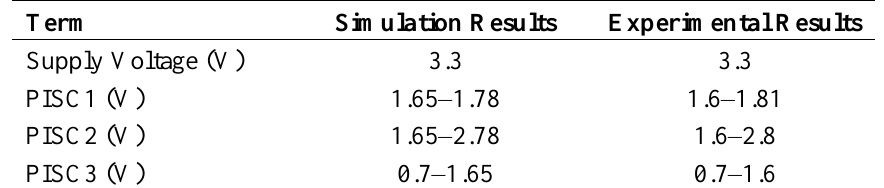
Table 6. Comparison of simulation and experimental results for PISC circuits.